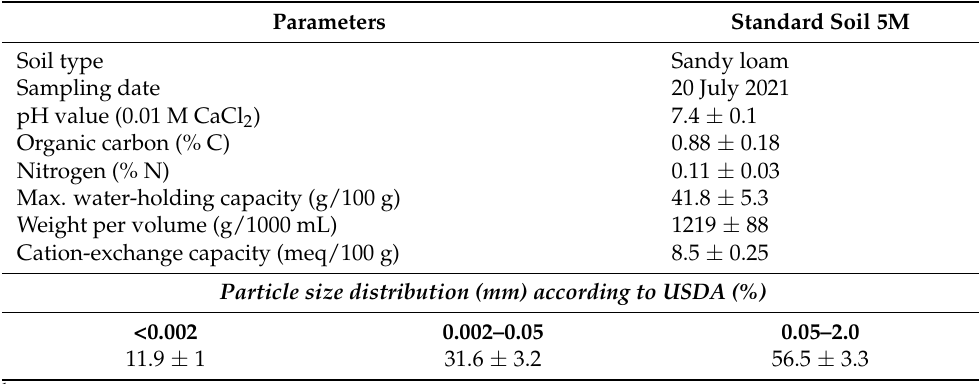
Table 1. Chemical and physical characteristics of standard soil 5 M 1